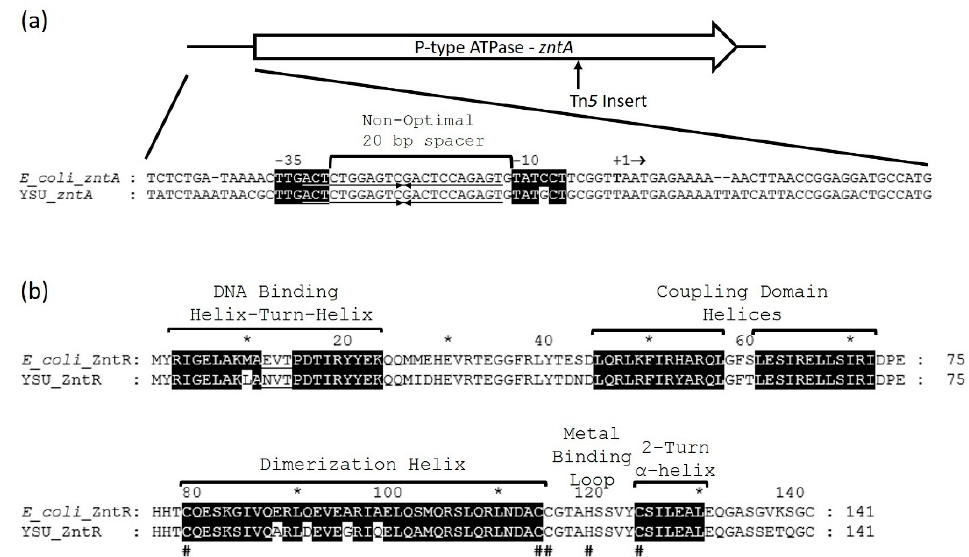
Figure 3. The Enterobacter sp. YSU zinc resistance ( znt ) operon and the ZntR activator/repressor switch. ( a ) The Enterobacter sp. YSU zntA gene and its predicted promoter region using the E. coli zntA promoter region. The gene for zntR is not adjacent to zntA and is located on a different region of the chromosome. An arrow indicates the Tn 5 transposon insertion sites in zntA . It inserted in almost the same site for both mutants. The promoter region contains a non-optimal 20 bp spacer region and a ZntR binding site (underlined arrows) between the predicted -10 and -35 regions. Identical nucleotides in the -10 and -35 regions are highlighted in black. The last three base pairs, ATG, on the far right marks the beginning of ZntA translation. ( b ) Prediction of the Enterobacter sp. YSU ZntR secondary structure using the E. coli ZntR amino acid residue primary sequence. Like MerR, the ZntR helix-turn-helix domain binds to the operator region of the promoter in the DNA. The coupling domain links the DNA binding domain to the metal binding domain. The metal binding domain consists of a dimerization helix, a metal binding loop and a 2-turn α -helix. The amino acids residues that are highlighted in black are identical to amino acid residues in the helices of E. coli ZntR. The # below the sequences designates cysteine and histidine amino acid residues which bind to Zn(II). The * and numbers above the ZntR primary sequences denote the position of every 10 amino acid residues.